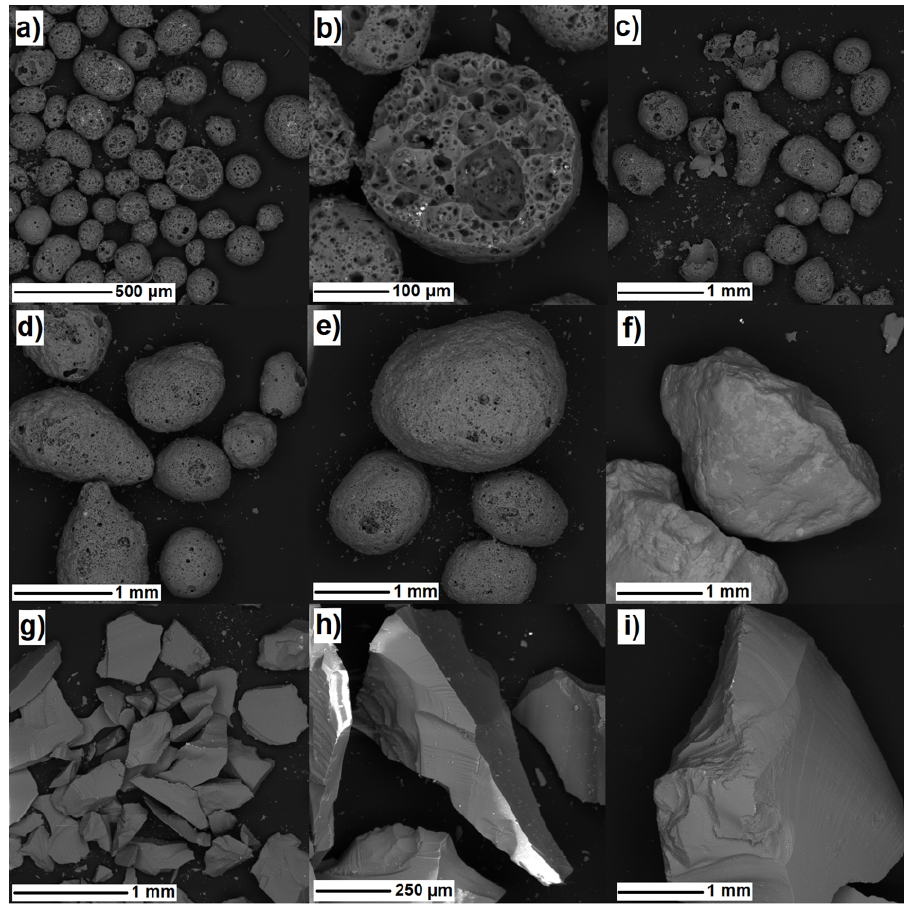
Figure 2. SEM micrographs of expanded glass fraction: ( a )–( b ) 0.125–0.250 mm; ( c ) 0.25–0.50 mm; ( d ) 0.5–1 mm; ( e ) 1–2 mm; ( f ) river sand fraction 2–4 mm; ( g ) crushed glass fraction 0.25–0.50 mm; ( h ) 0.5–1 mm; ( i ) 1–2